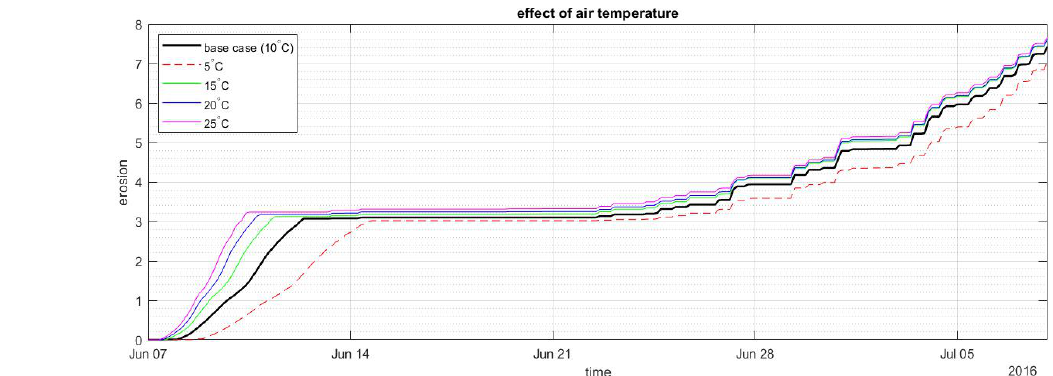
Figure A12. The effect of air temperature inputs on